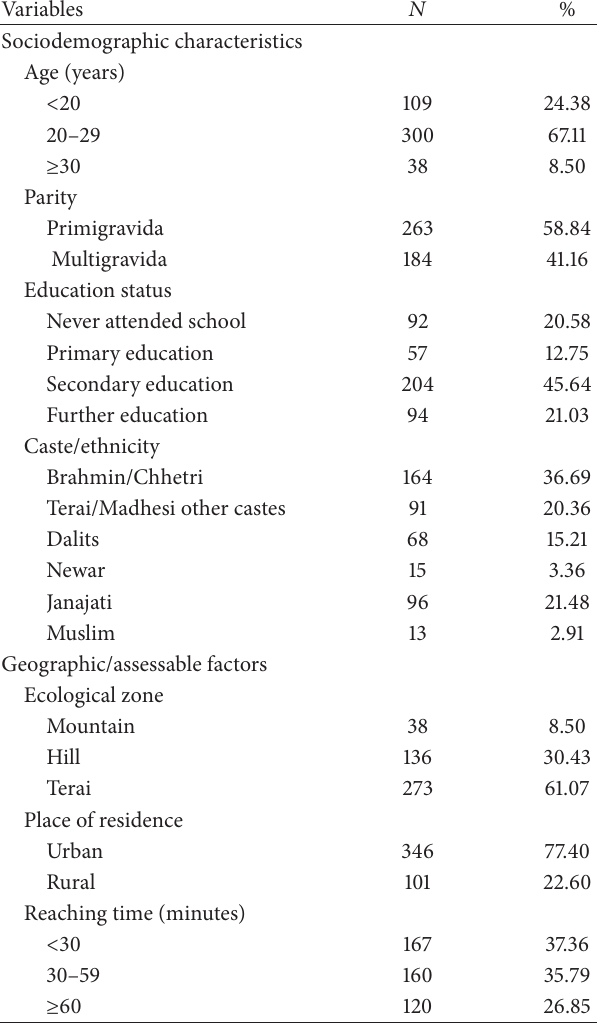
Table 1: Sociodemographic characteristics and geographical/acces- sibility factors of maternity clients ( 𝑁 = 447